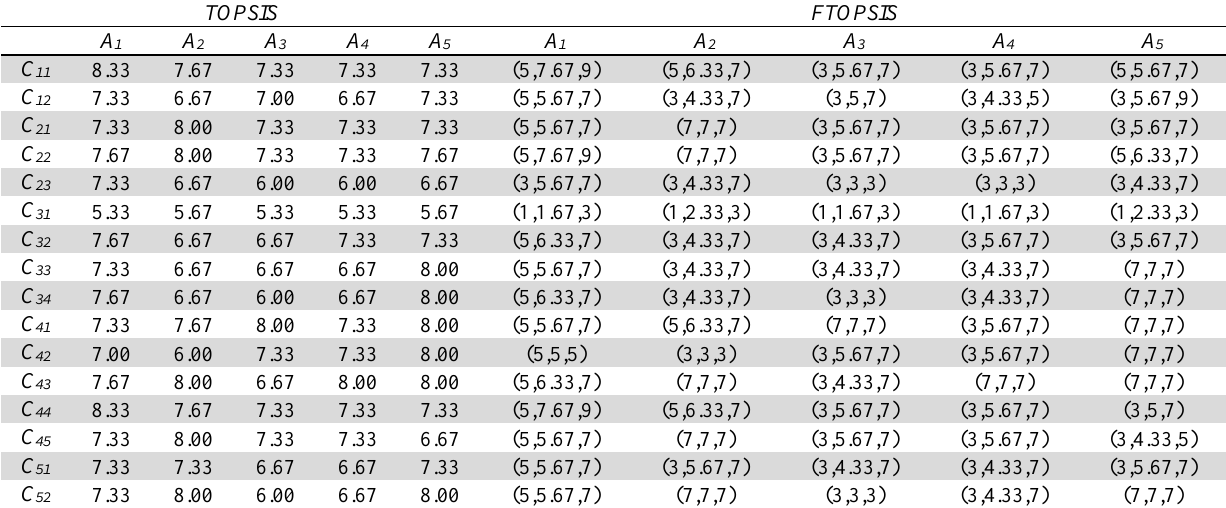
Aggregated decision matrix of TOPSIS & FTOPSIS methods